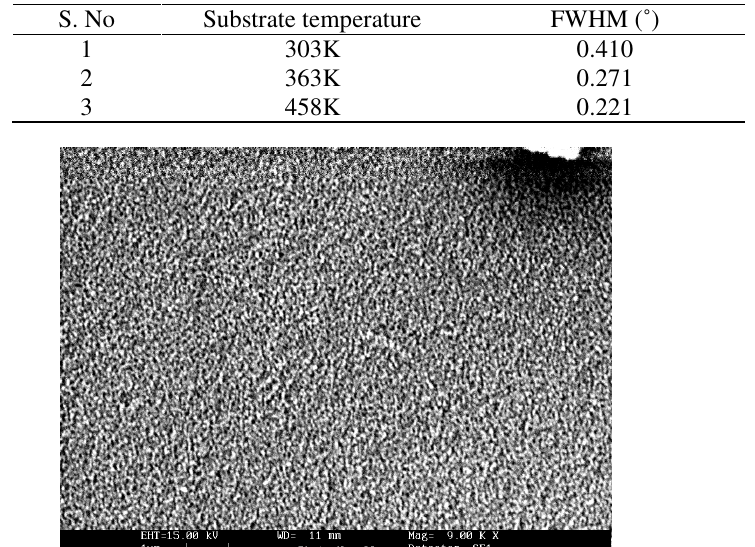
Table 2. Variation of FWHM of preferential orientation with substrate temperatures for the NiPc thin films.